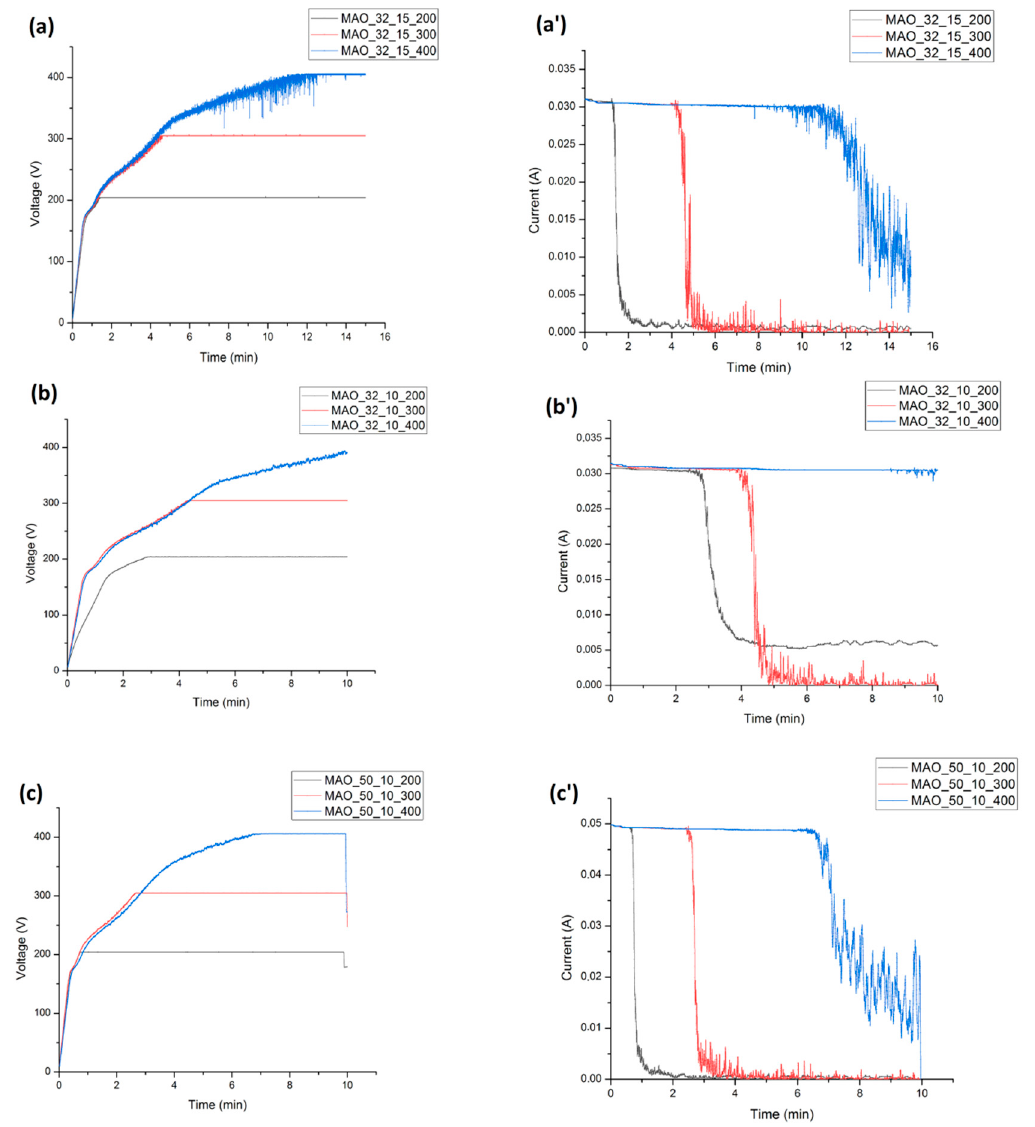
Figure 1. Time-dependent curves of voltage ( a – c ) and current ( a’ – c’ ) of the MAO process for MAO_32_15 ( a , a’ ), MAO_32_10 ( b , b’ ), and MAO_50_10 ( c , c’ ).